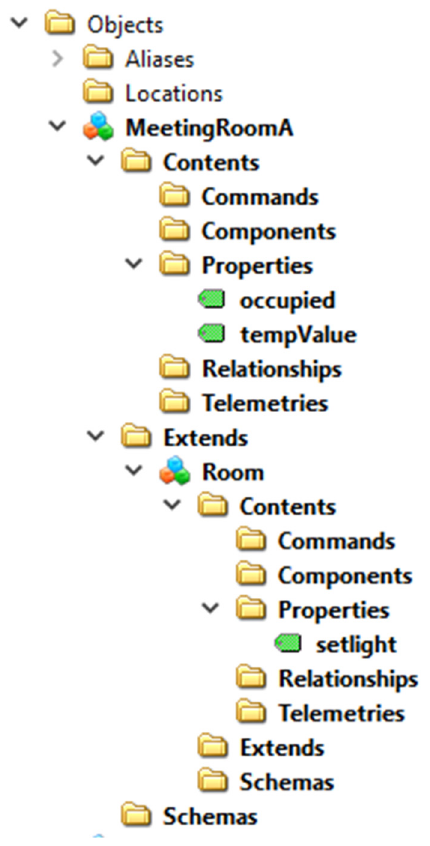
Figure 14. OPC UA Nodes representing MeetingRoomA in the OPC UA domain.